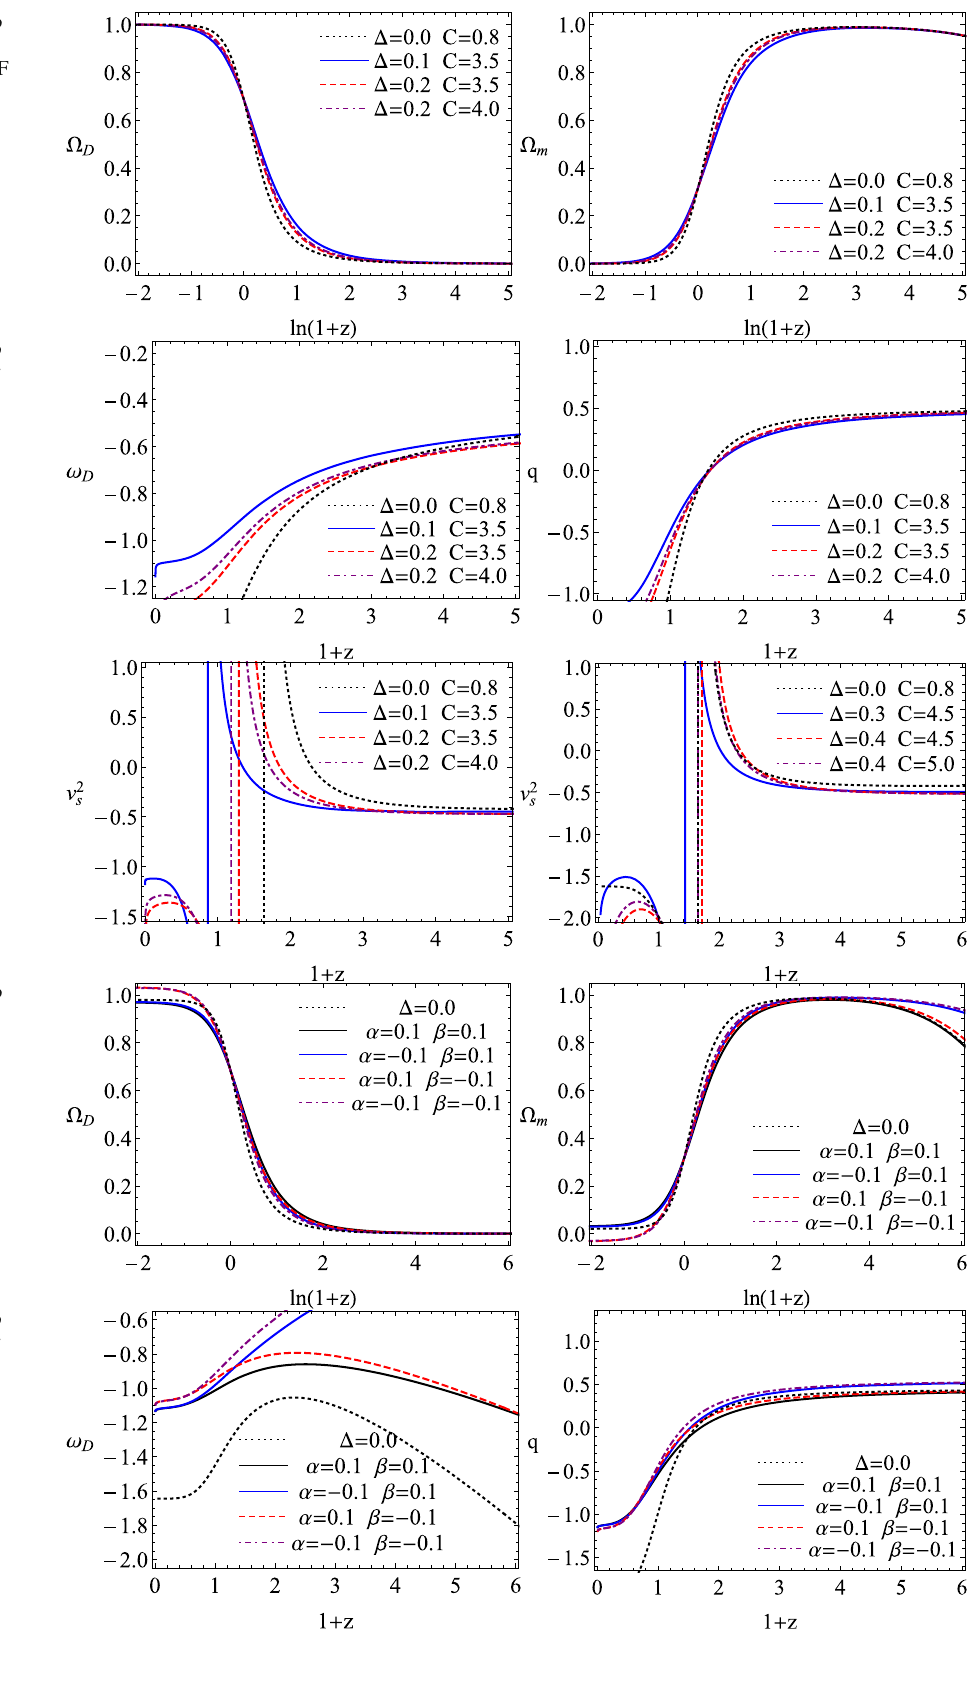
Fig. 5 Evolution curves of w D and q versus redshift parameter 1 + z for